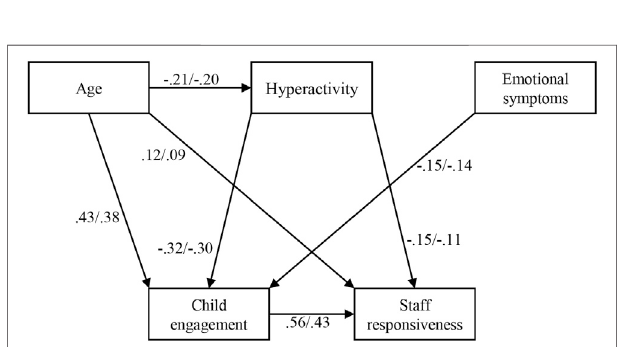
FIGURE 3 | Multi-group staff responsiveness model paths. Note: To the leftoftheslashpunctuationofeachpathisthepathcoef fi cientforL1-learners, and to the right is the path coef fi cient for L2-learners (L1-learners coef fi cient/ L2-learnerscoef fi cient).Allpathswere p < 0.01.*indicatesthattherewas a signi fi cant path between the two